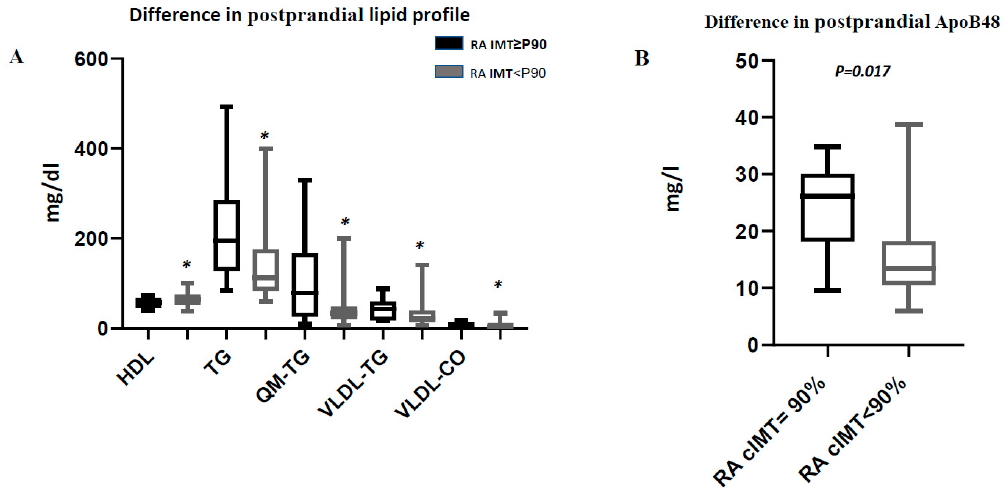
Figure 2. Postprandial lipid profile amongRA patients with cIMT ≥ 90% and cIMT<90%. ( A ) Difference in postprandial lipid profile. * Indicates significant differences ( p -value ≤ 0.05). ( B ) Difference in